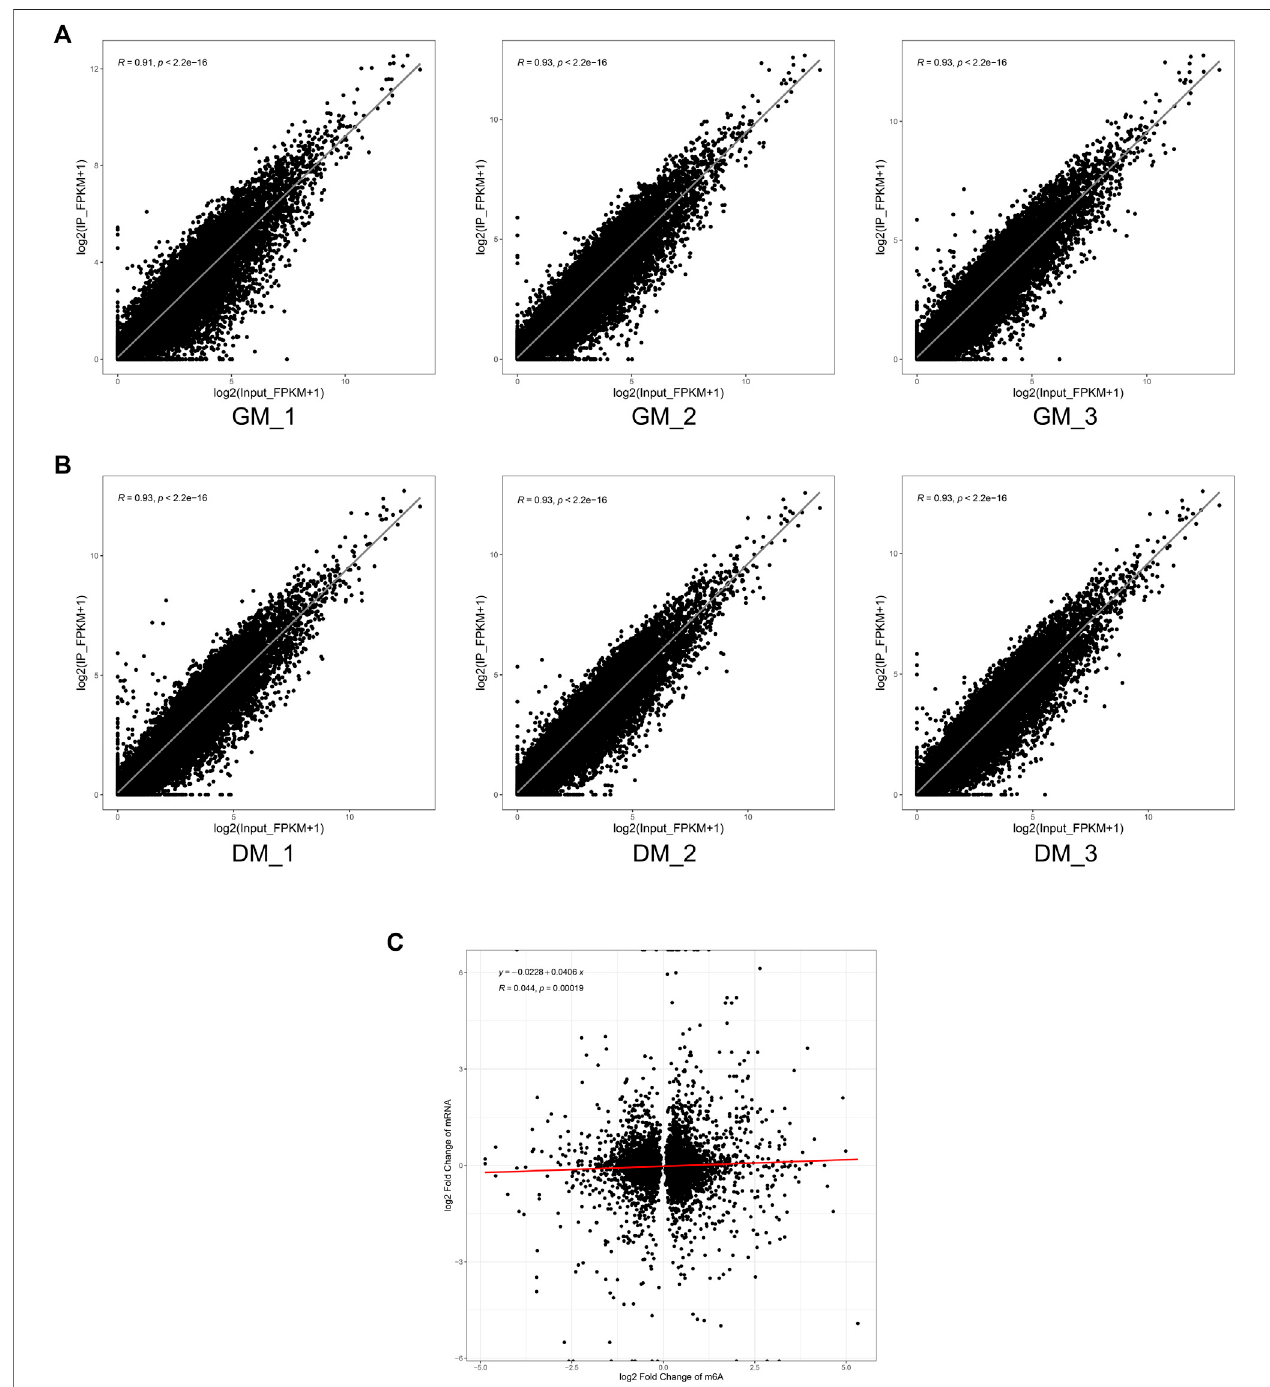
FIGURE6| Correlationanalysisofm 6 ApeakenrichmentandmRNAabundanceinbovinemyoblastsandmyotubes. (A) Scatterplotsofm 6 ApeakenrichmentandmRNA abundanceinthreebiologicalreplicatesofGMshowingthesametendency. (B) Scatterplotsofm 6 ApeakenrichmentandmRNAabundanceinthreebiologicalreplicatesofDM showing the same tendency. (C) Scatter plots showing a weak correlation between the fold changes in m 6 A methylation and mRNA expression levels for genes.